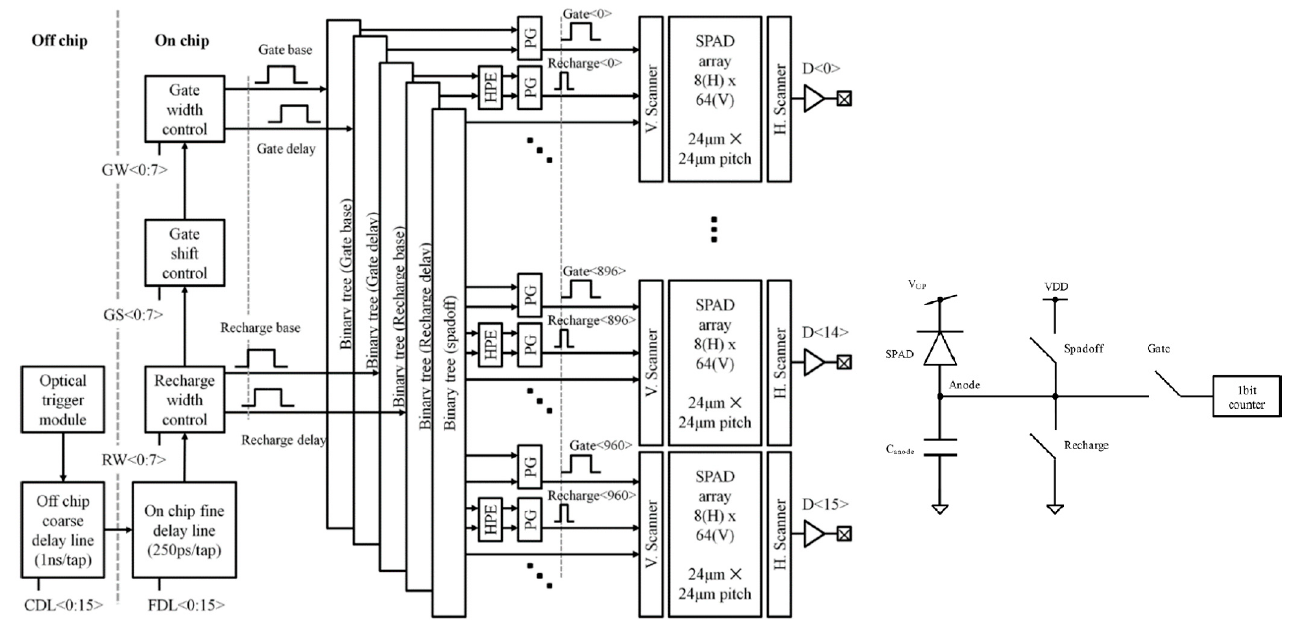
Figure 8. Block diagram of the 1024 × 8 Time-Gated SPAD Line Sensor in [66], with details on control signals used by each gated SPAD.